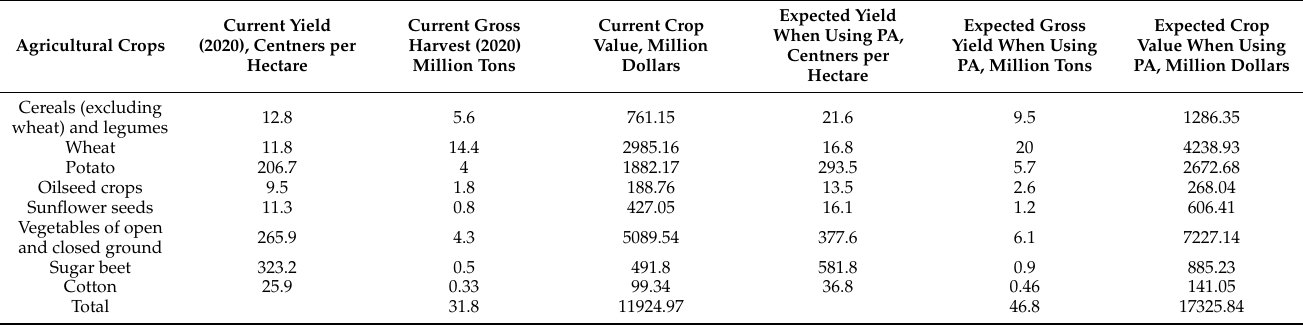
Table 1. Comparison of current and expected crop